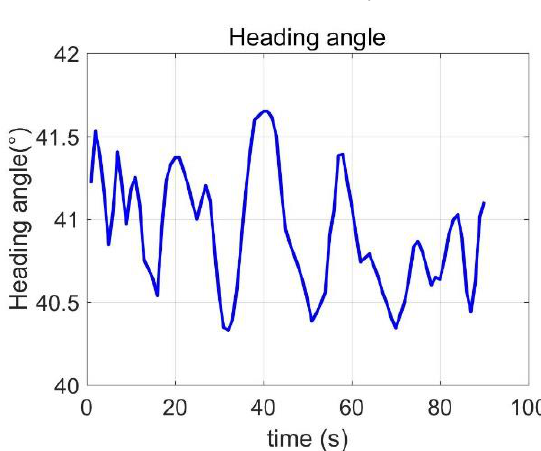
Figure 9. Three-axis velocity errors.